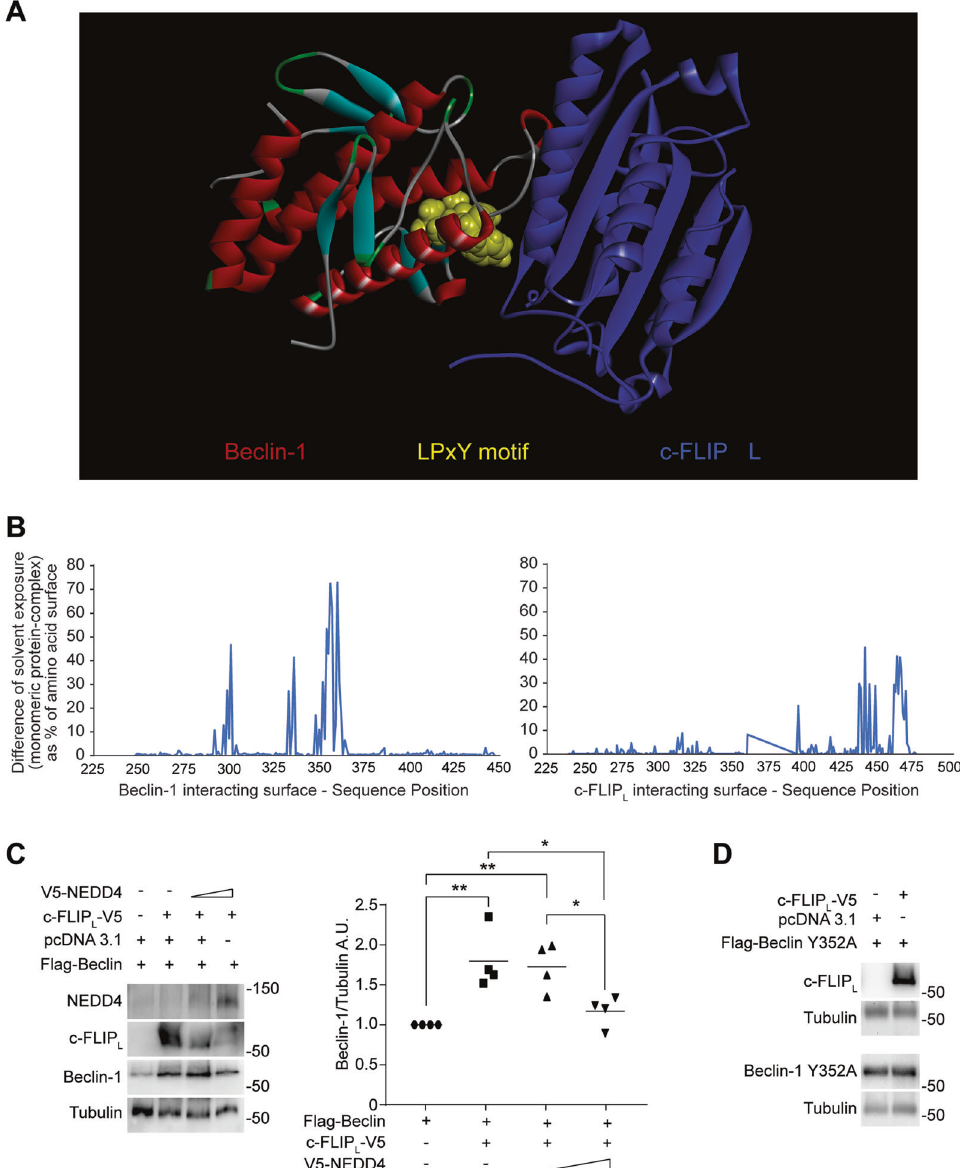
Fig. 5 Bioinformatics simulation and biochemical data correlate with a competition dynamic between c-FLIP L and NEDD4. A The interaction between Beclin-1 and c-FLIP was simulated. Beclin-1 (on the left) is shown as a backbone ribbon with standard colours (red = helices, cyan = β -strand, green = turn). The 349 – 352 region, which is reported in literature as being involved in the interaction with NEDD4, is highlighted in yellow. The region is near the surface of interaction with the c-FLIP molecule (on the right), shown with backbone ribbon in blue. B The graph evidences the sequence regions of Beclin-1 and of c-FLIP involved into the interaction between the two molecules as it reports the difference of solvent exposure of amino acids from the monomeric to the complex structure. Values > 0 indicate amino acids that are solvent exposed in the monomeric structure and are not accessible, or less accessible, to the solvent in the complex, i.e., at the interface with the interacting molecule. C Hek293 cells were transfected to overexpress c-FLIP (c-FLIP L -V5), Beclin-1 (Flag-Beclin) and NEDD4 (V5- NEDD4). Beclin-1 protein expression was then detected by western blotting. α -Tubulin was used as a loading control. Data shown are representative of at least three individual experiments. * p < 0.05, ** p < 0.01 determined by one-way ANOVA. D Hek293 cells were transfected to overexpress c-FLIP (c-FLIP L -V5) and Beclin-1 mutant (Flag-Beclin Y352A). Beclin Y352A protein expression was studied by western blot analysis. α -Tubulin was used as a loading control. Data shown are representative of three individual